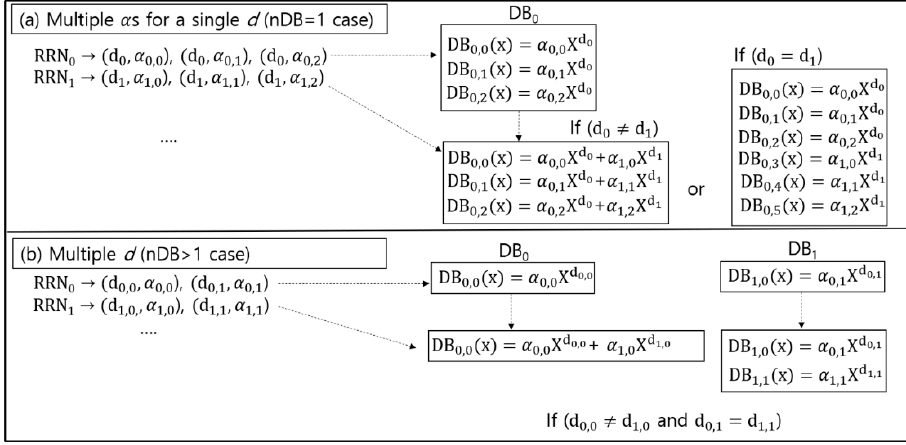
Figure 5. Encoding formatted data to polynomials (when nDB = 1, 2).